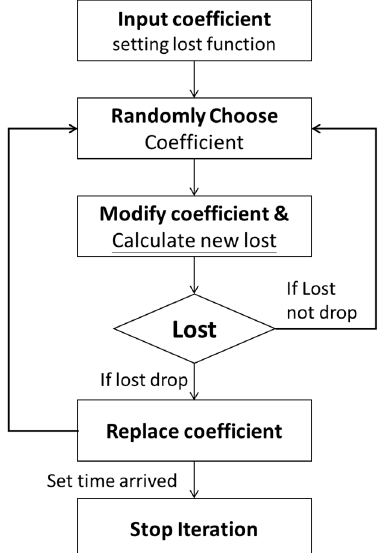
Figure 11. Modification coefficients workflow.